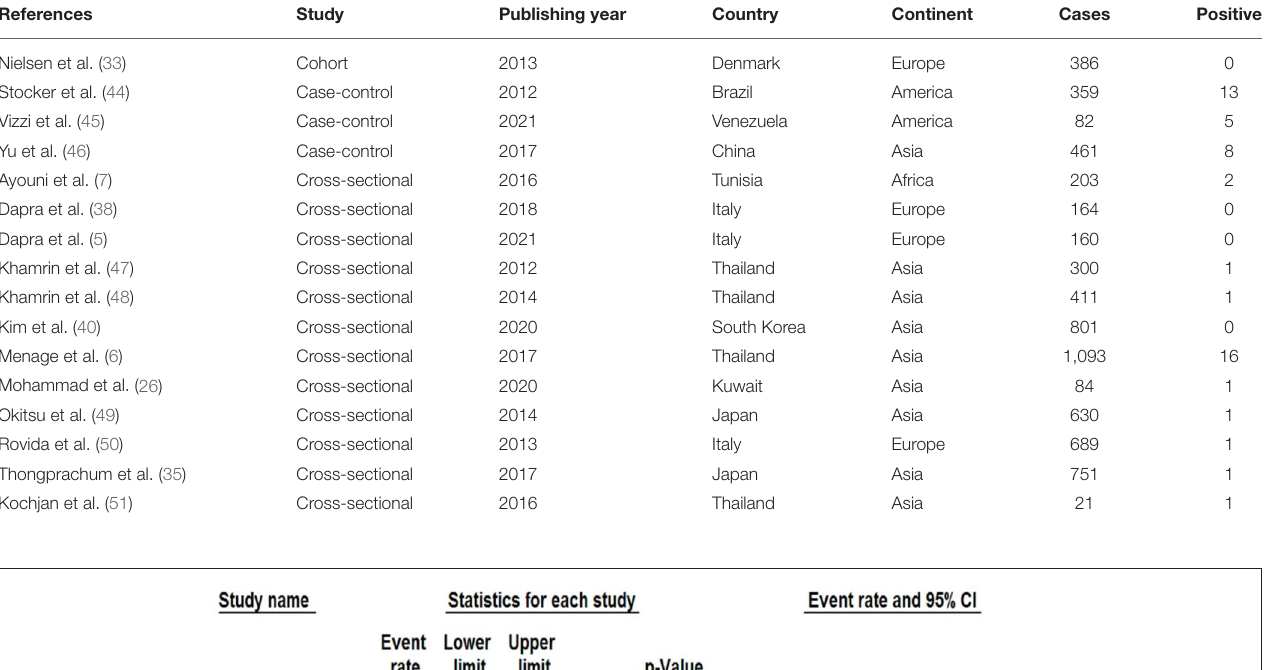
TABLE 3 | The general characterization of Cosavirus studies.